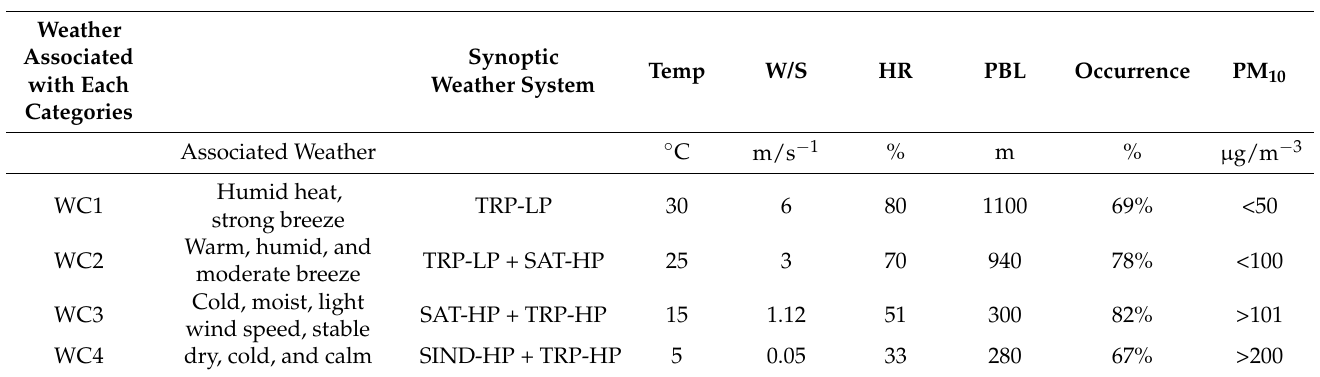
Table 4. Results for the atmospheric weather classification which influence the occurrence of dif- ferent PM 10 concentration categories. The meaning of all synoptic weather conditions are as fol- lows: (a) Tropical low pressure (TRP-LP); (b) Tropical low pressure and South Atlantic Ocean high pressure (TRP-LP + SAT-HP); (c) South Atlantic ocean high-pressure and Tropical high pressure (SAT-HP + TRP-HP); (d) South Indian Ocean high pressure and Tropical high pressure (SIND-HP +